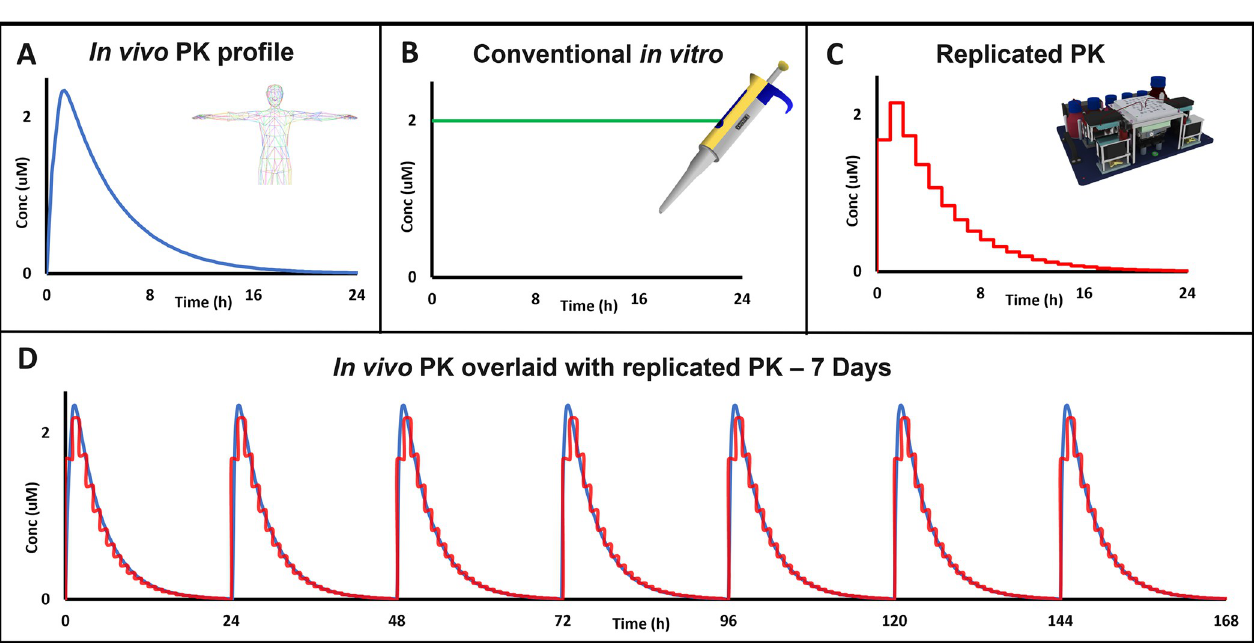
Fig 1. Improving translation of in vitro assays requires incorporating in vivo drug exposure profiles. (A) In contrast to the dynamic peak and trough exposure profile that occurs in vivo reflecting drug absorption, distribution, and elimination, most in vitro assays (B) use a static, fixed bolus concentration of drug for the duration of the assay. (C) The Microformulator can replicate a PK profile and can (D) repeat the profile for multiple days/weeks to enable PK-PD- efficacy testing in vitro to determine the degree of target inhibition and the duration of inhibition required for a biological response. PD, pharmacodynamics; PK,